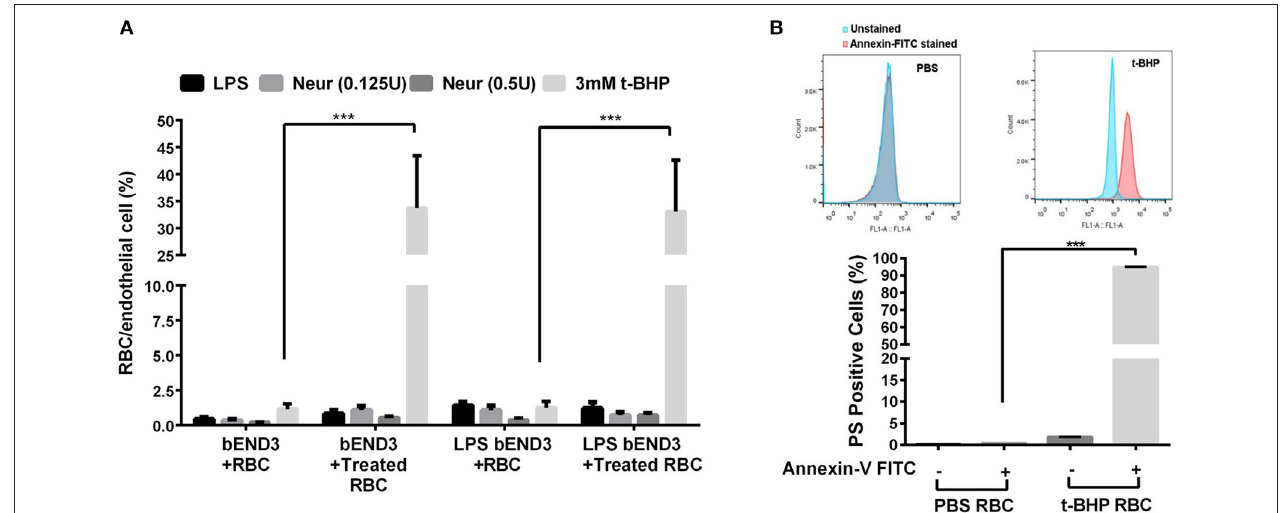
FIGURE 1 | RBC adhesion to brain endothelial (bEND3 cells) under different conditions (A) and PS exposure in t-BHP-treated RBC (B) . RBC treated with PBS (control), LPS (10 µ g/mL) or neuraminidase (0.125U or 0.5U) did not significantly alter RBC adhesion to bEND3 cells following 3h incubation, however, 3mM t-BHP treatment of RBC resulted in a significant increase in RBC adhesion to bEND3 cells compared with respective PBS-treated RBC. LPS treatment of bEND3 cells did not further enhance RBC adhesion under any treatment conditions. > 90% of 0.3mM t-BHP-treated RBC were PS positive compared with PBS-treated RBC as determined by flow cytometry (B) . Data is presented as mean ± SEM of at least 3 independent experiments. *** p <